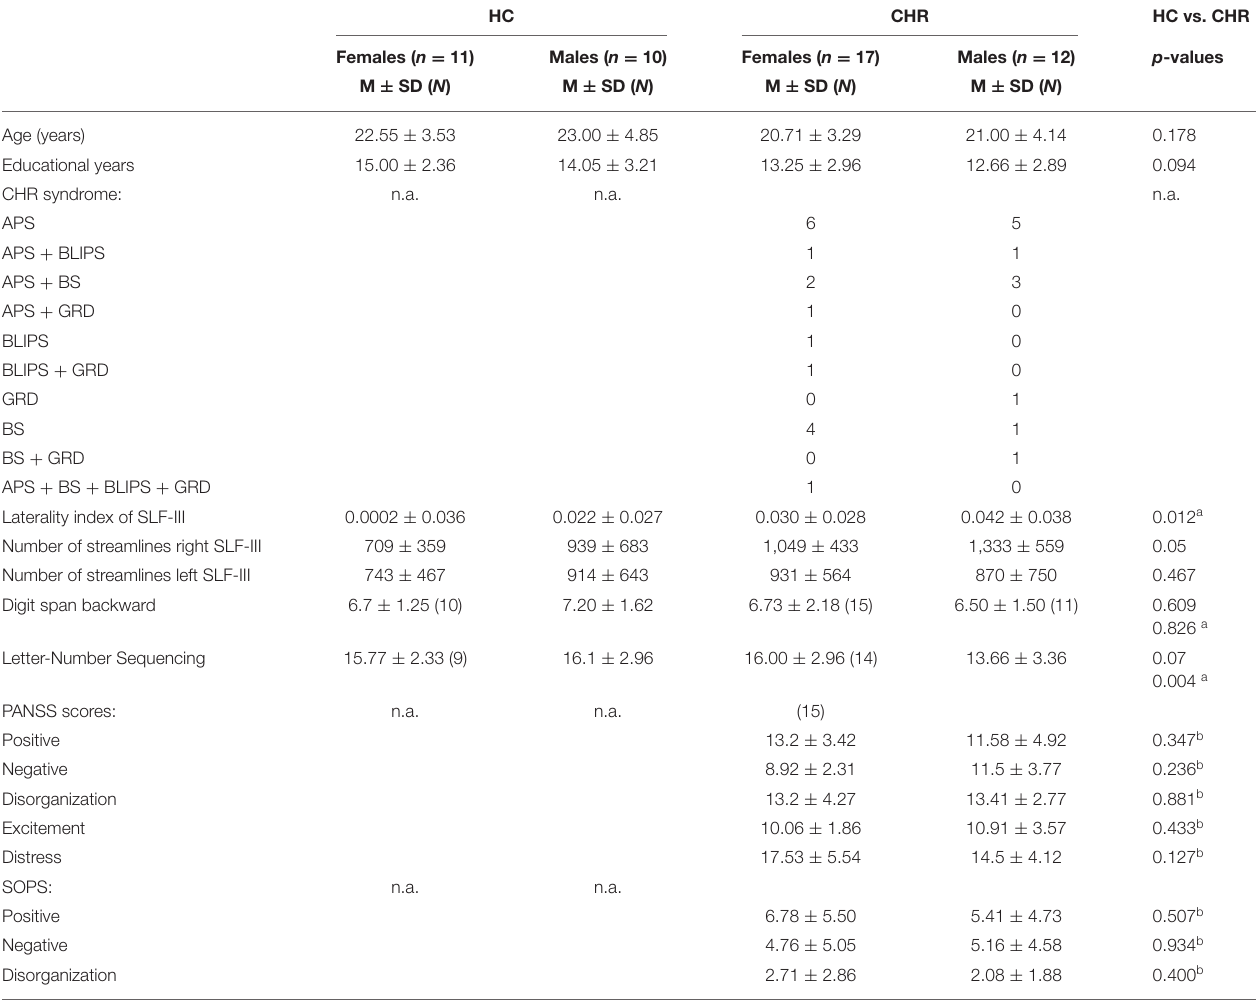
TABLE 1 | Sociodemographic and clinical characteristics of the sex-related